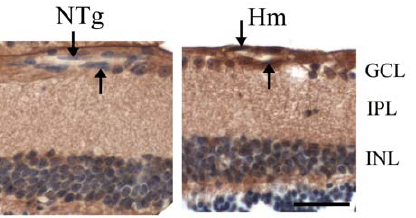
Figure 2. Immunohistochemical staining of ET-1 antibody. Immunoreactivity of ET-1 was up-regulated in the endothelial cells (arrows) of Hm TET-1 mice compared with the corresponding NTg mice. Scale bar=25 m m.